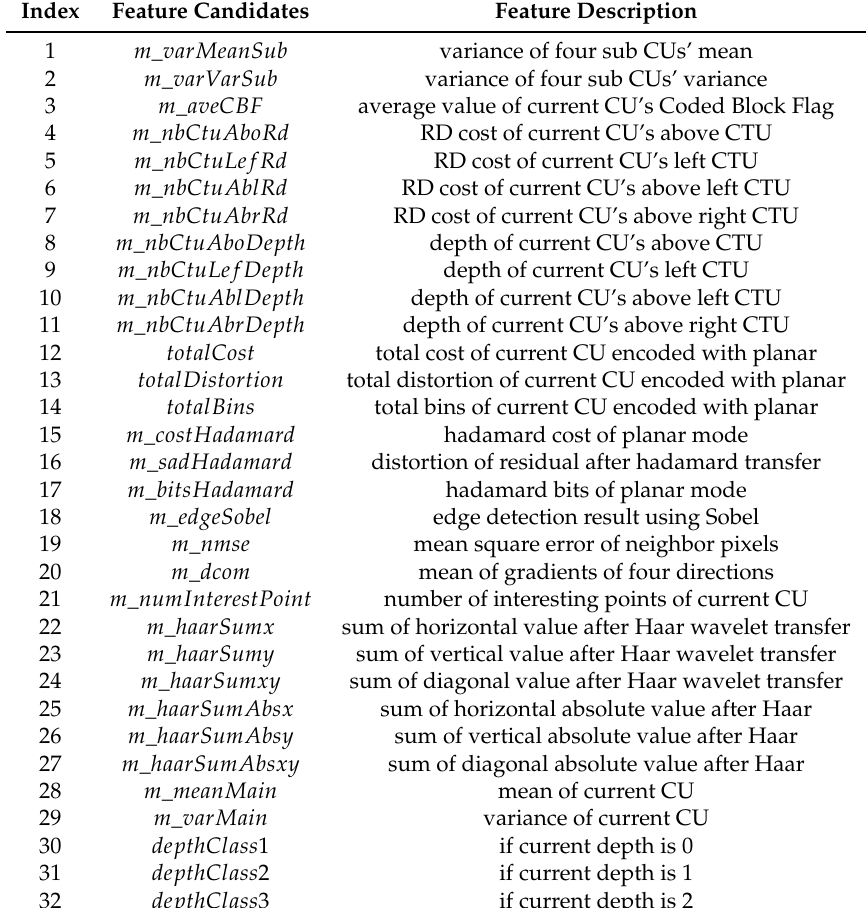
Table 1. Feature candidates taken into